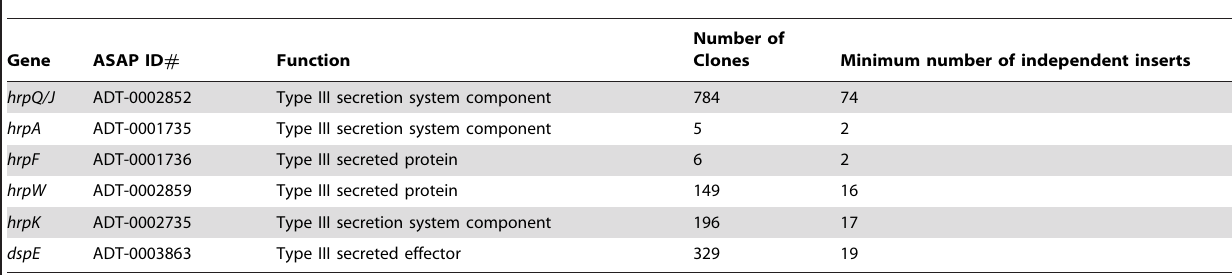
Table 1. HrpL-regulated genes found in the DFI screen.